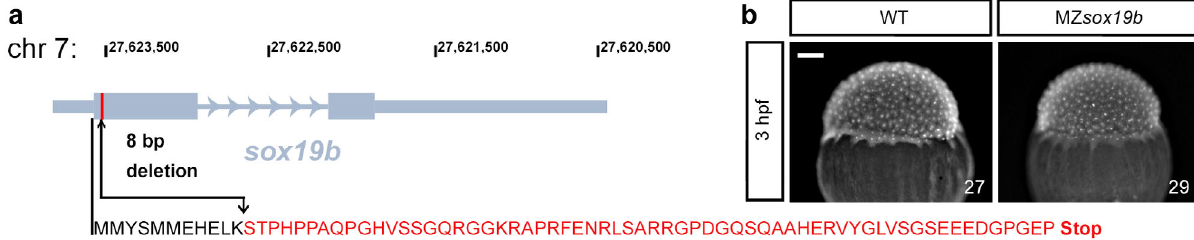
NATURE COMMUNICATIONS| (2022) 13:788 |https://doi.org/10.1038/s41467-022-28434-1|www.nature.com/naturecommunications